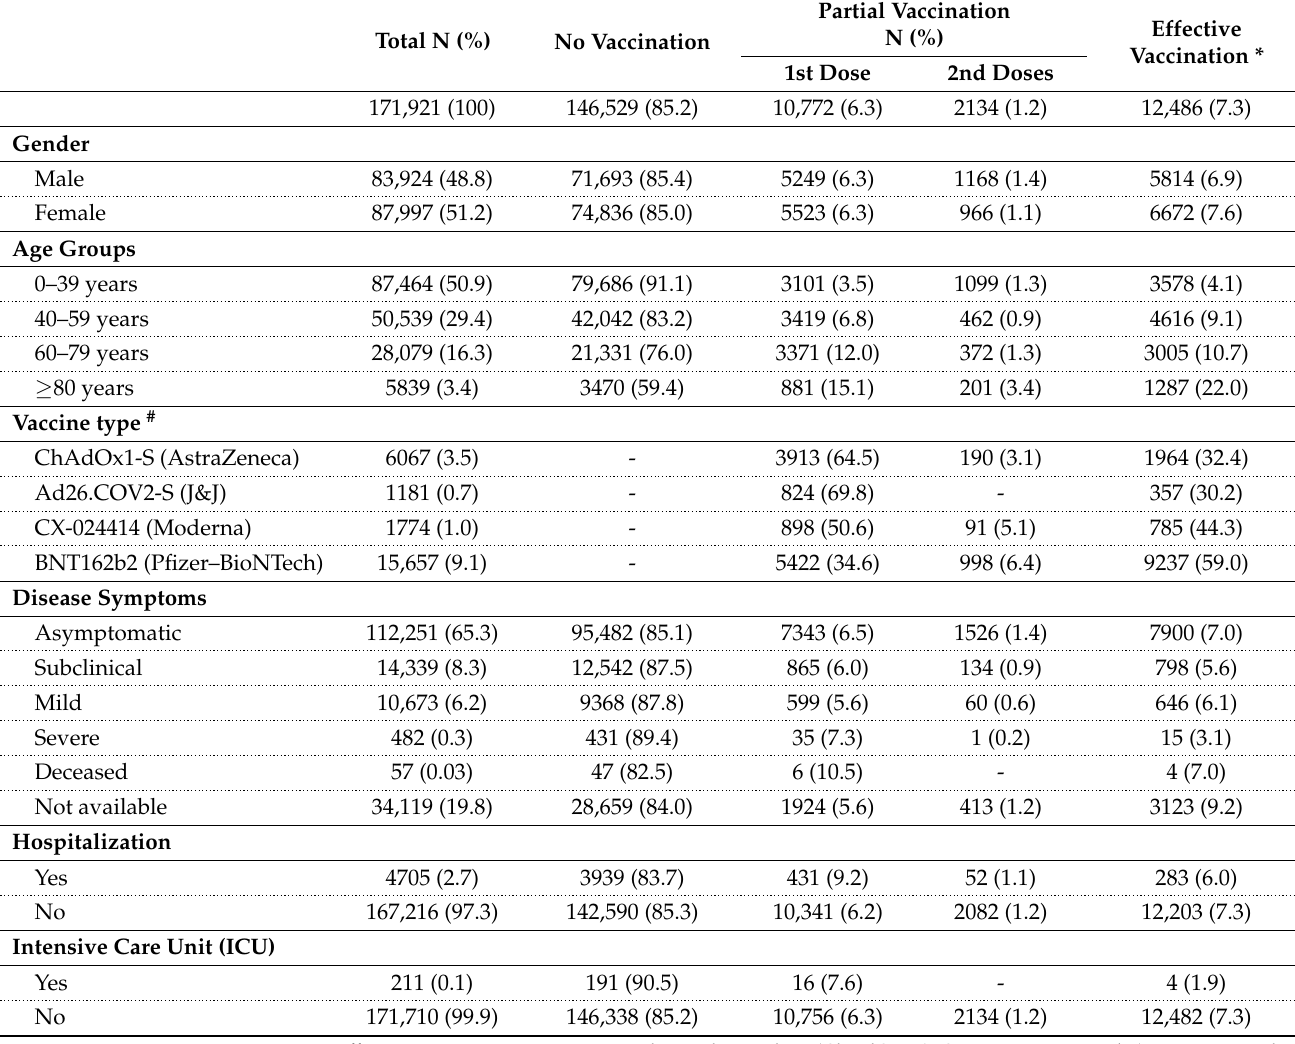
Table 1. General characteristics of COVID-19 positive patients.